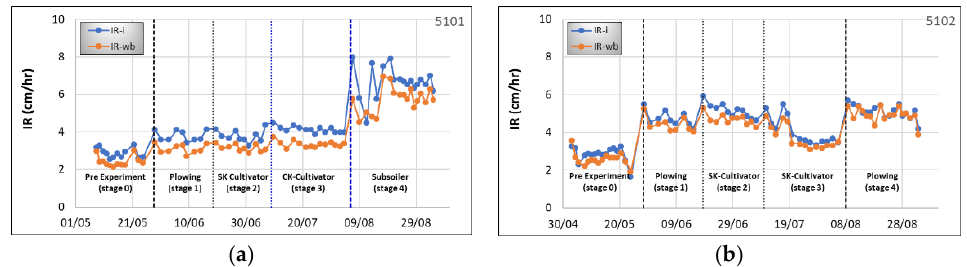
Figure 3. Infiltration rates measured in two representative ponds during the experiment: ( a ) Pond #5101 with new tillage tools at Stages 3 and 4 (treatment); ( b ) Pond #5102 with existing tillage tools only at all stages (control).